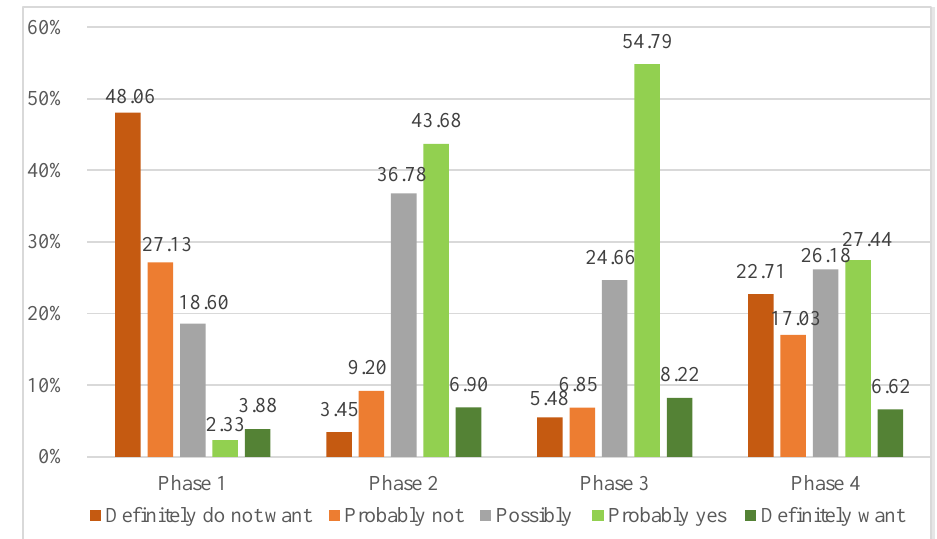
Figure 2. Willingness to limit meat in the diet depending on phase of change in meat consumption.